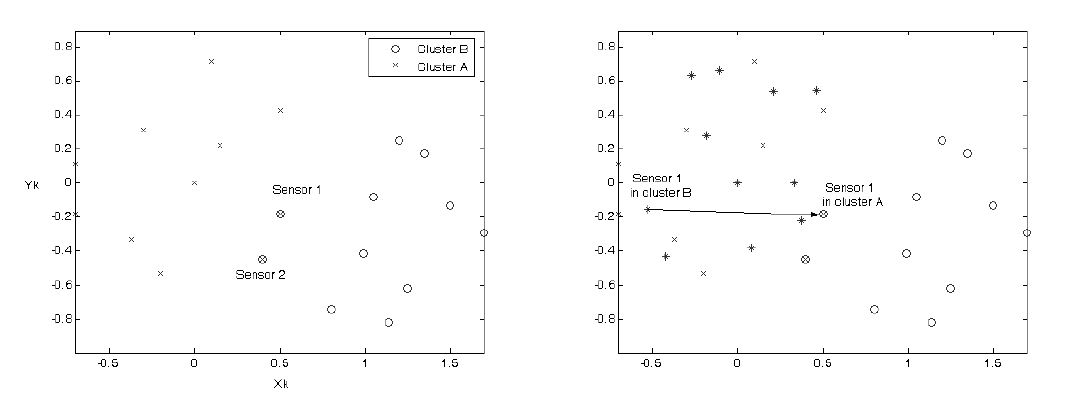
Figure 14. The global coordinate system of cluster A and cluster B (left); the local coordinate systems of cluster A and cluster B and the shifting direction of cluster B (right).